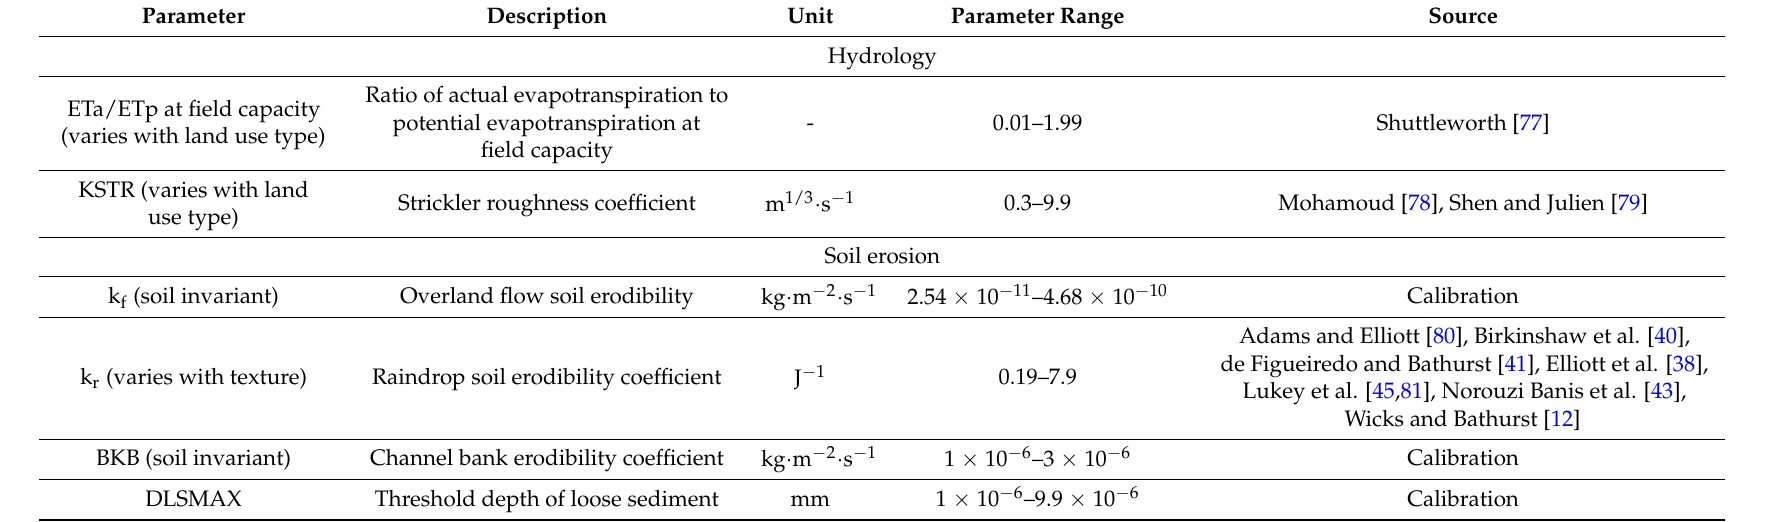
Table 5. Soil, land use and erosion parameters in